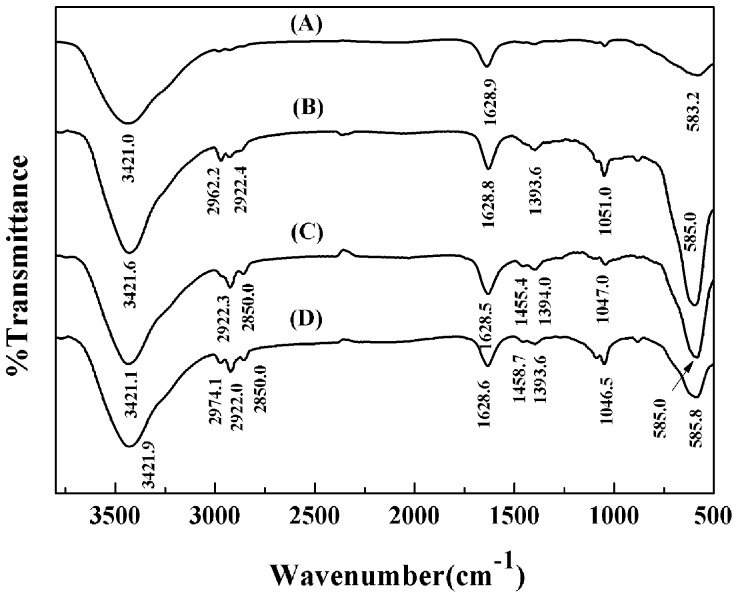
FTIR spectra of Fe3O4 (A), C3-Fe3O4 (B), C8-Fe3O4 (C), and C18-Fe3O4 (D) nanoparticles.